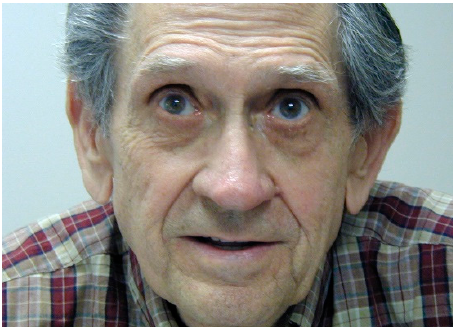
Figure 16. Viewing eccentrically. This man stated he was looking straight ahead into the camera.